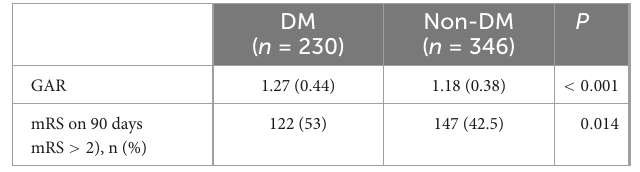
TABLE 1 GAR and 3-month prognosis between DM patients and non-DM